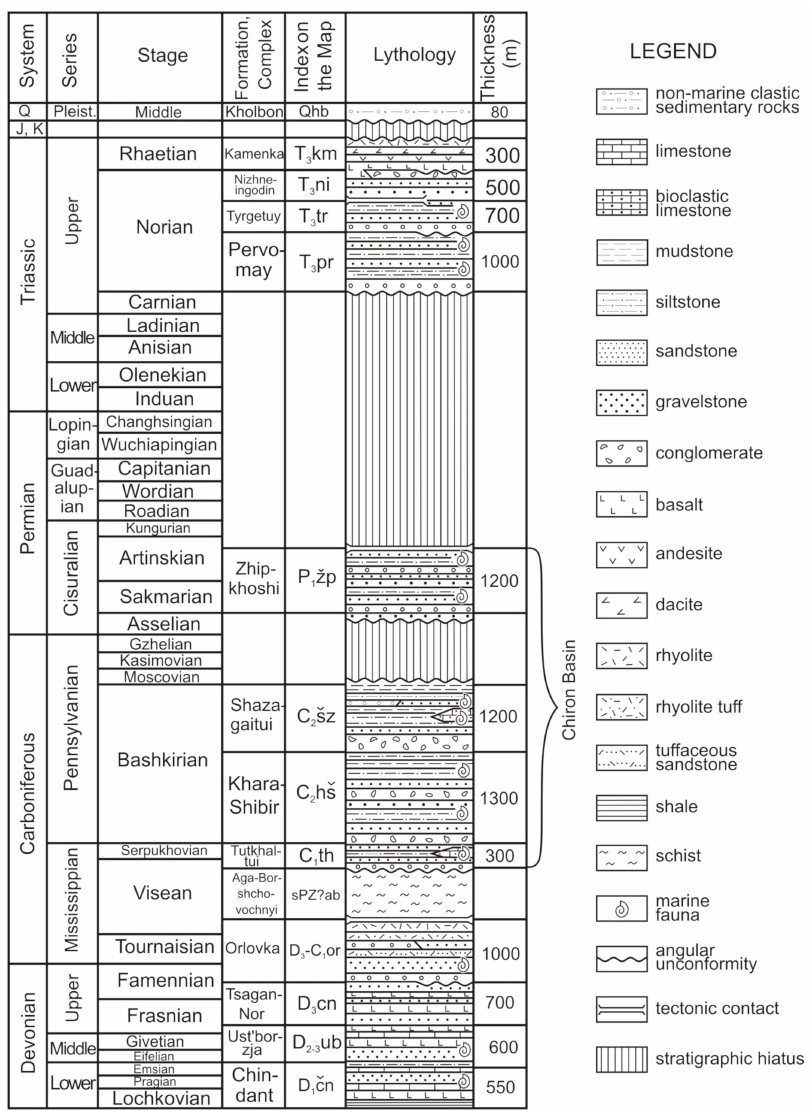
Figure 3. Simplified stratigraphic column for the sedimentary rocks of the Chiron Basin as well as underlying and overlapping formations (modified after